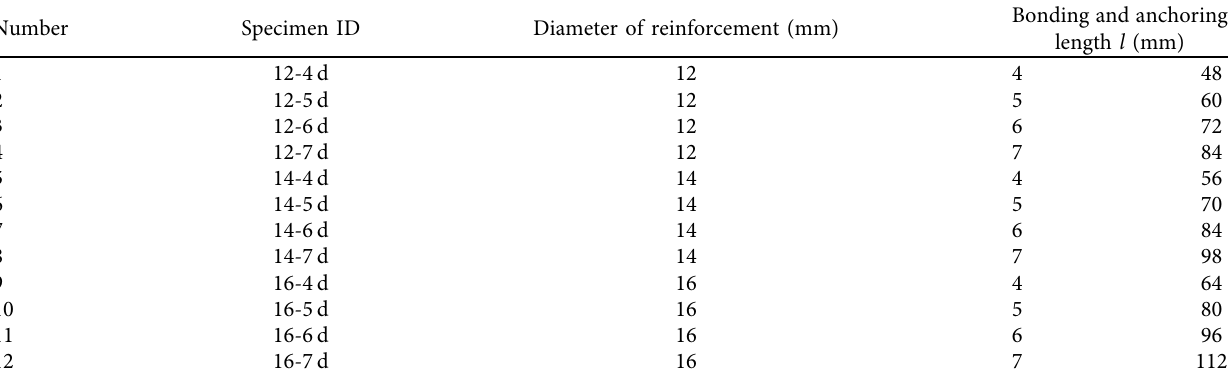
Table 10: Pull-out test of steel reinforcement bonded to polyurethane